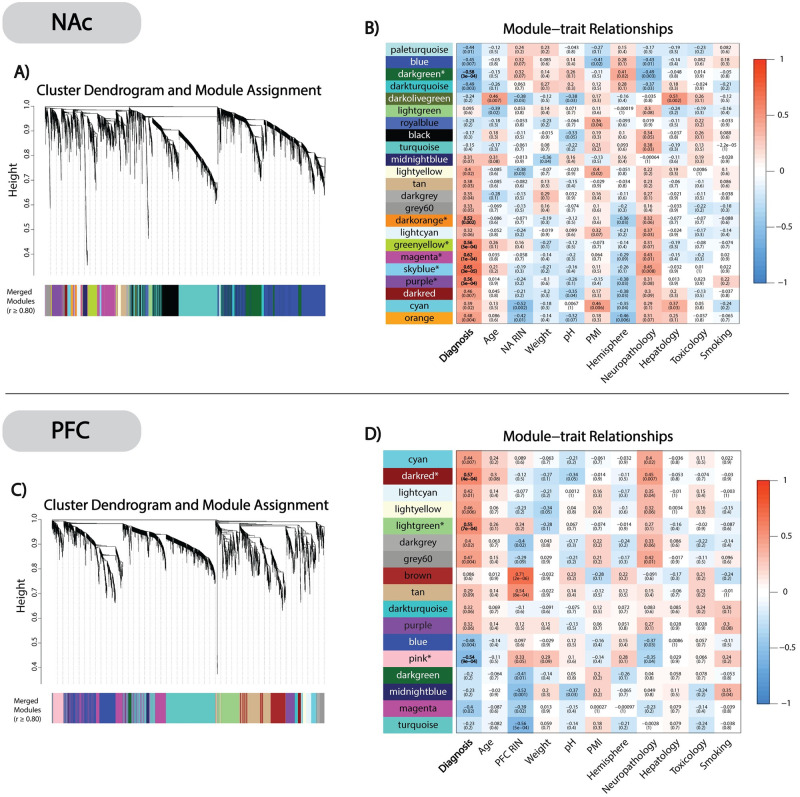
WGCNA clustering and module-trait relationships.A) NAc cluster dendrogram and module assignment with dissimilarity based on topological overlap. The 6,401 selected transcripts were clustered into 23 distinct modules. B) NAc module-trait relationship heatmap correlating (Pearson’s) module MEs with AD diagnosis and covariates. Uncorrected p-values are given in parenthesis below each correlation coefficient. 6 AD associated significant modules (NAcdarkgreen, NAcdarkorange, NAcgreenyellow, NAcmagenta, NAcskyblue, and NAcpurple,) were identified after Bonferroni correcting p-values (* = p≤0.05). C) PFC cluster dendrogram and module assignment. The 3,536 selected transcripts were clustered into 17 different co-expressed modules. D) PFC module-trait relationship heatmap created as previously described. We identified 3 AD associated modules (PFCpink, PFCdarkred, and PFClightgreen) after Bonferroni correcting p-values (* = p≤0.05).